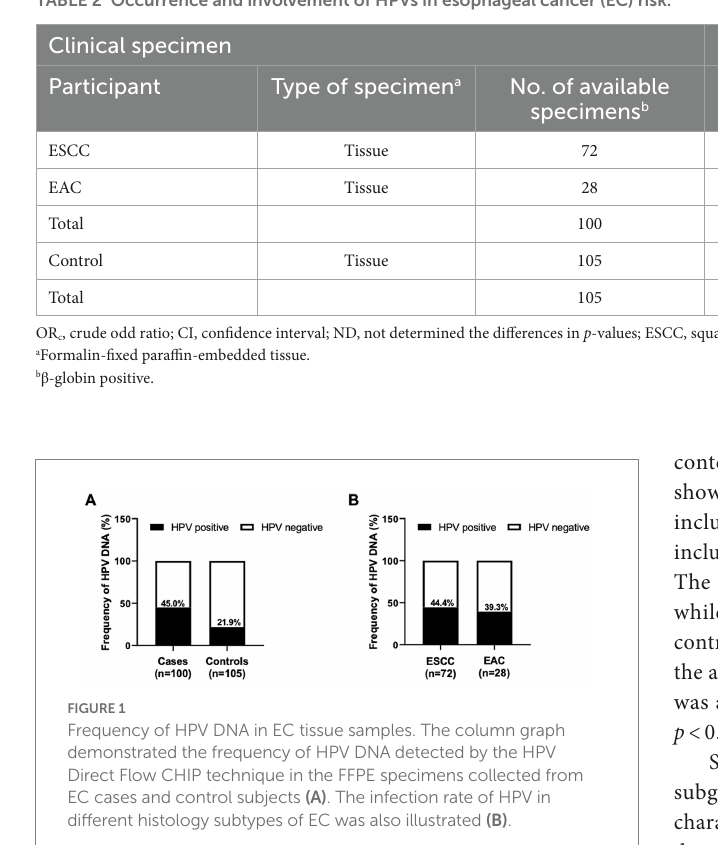
TABLE 2 Occurrence and involvement of HPVs in esophageal cancer (EC) risk.